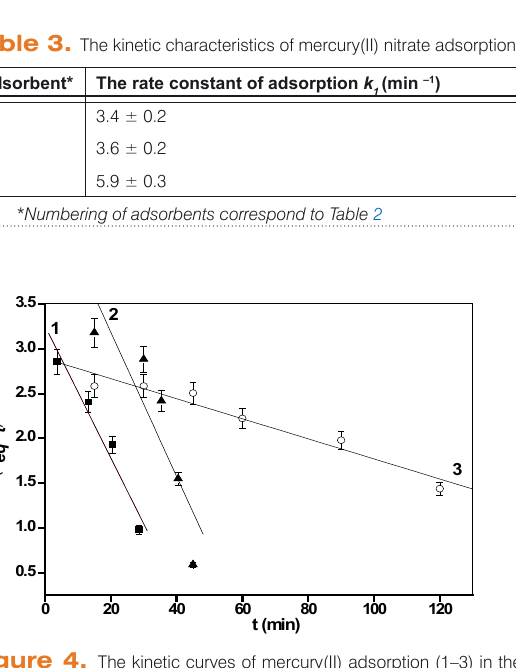
Figure 5. Isotherms of mercury(II) adsorption (1–3) from mercury(II) nitrate aqueous solutions for adsorbents 1–3 respec- tively.